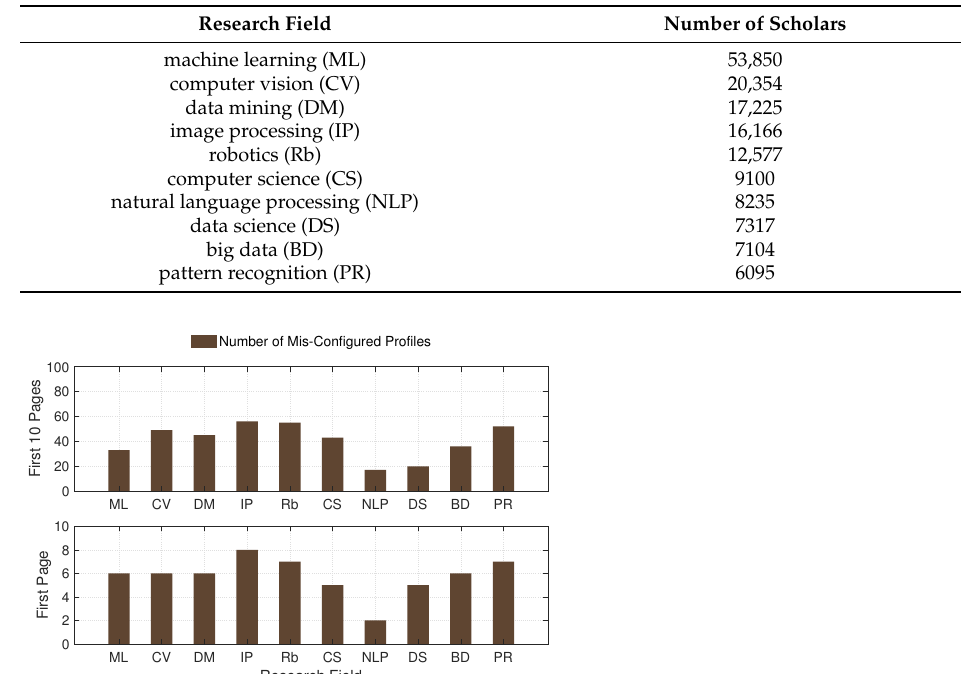
Table 6. Number of scholars in the top 10 research fields.